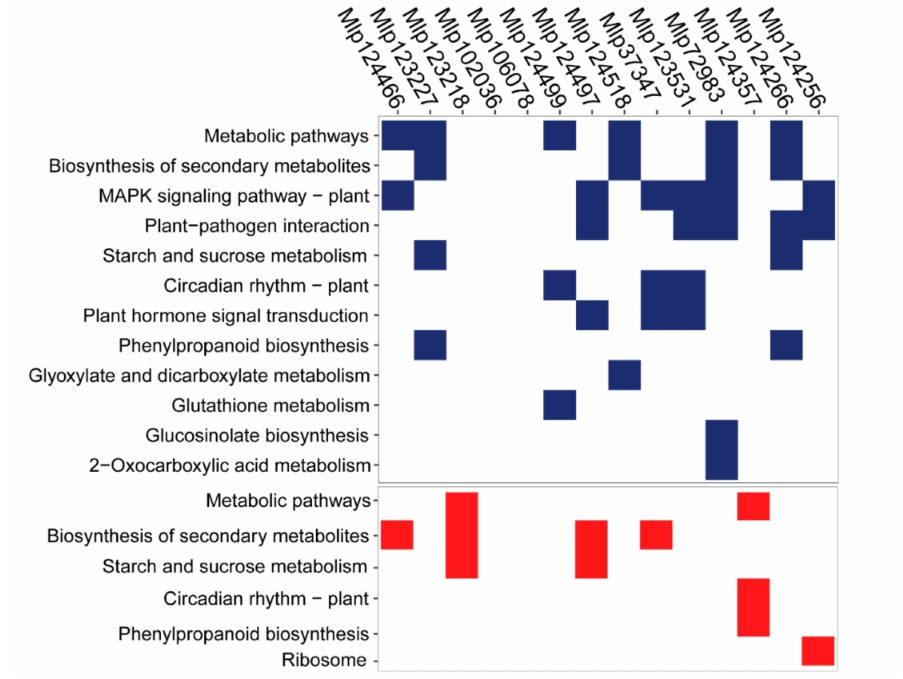
Figure 4. Effectors converge on deregulating the same metabolic pathways while others display unique patterns. KEGG pathways over-represented among the sets of down- (blue) and up- (red) regulated genes in each transgenic line (columns) were calculated with KEGGprofile. Transgenic lines are ordered according to dendrogram of sequence similarity calculated with Muscle and UPGMA. The underlying data for this figure can be found in the study by dos Santos et al.